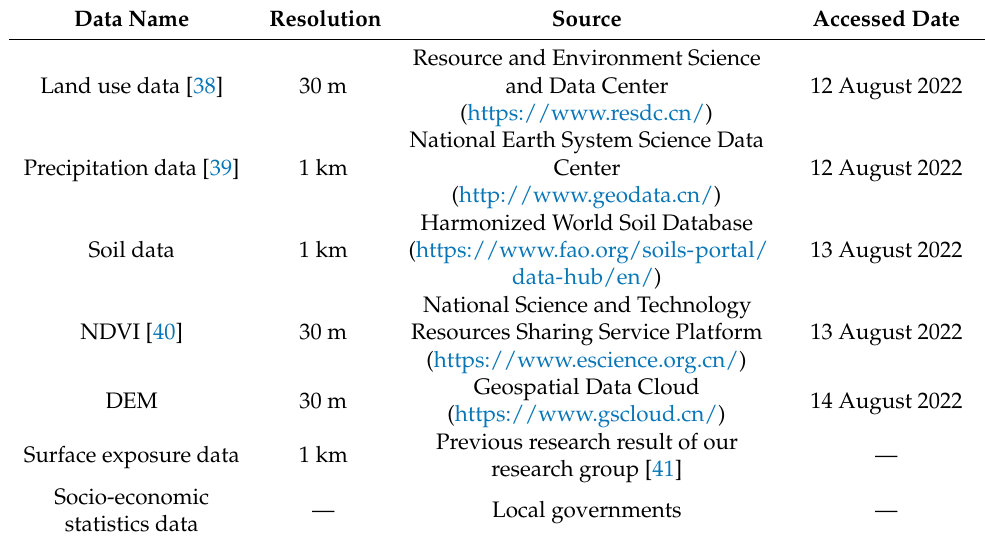
Table 1. Data name, source, and other information.